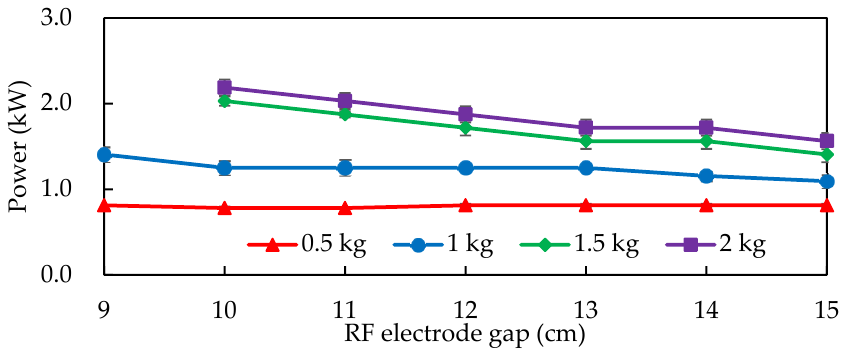
Figure 2. Effect of different loading levels of almonds and different 5 kW, 40.68 MHz RF electrode plate gaps on power. Data are expressed as mean ± S.D. ( n = 3).